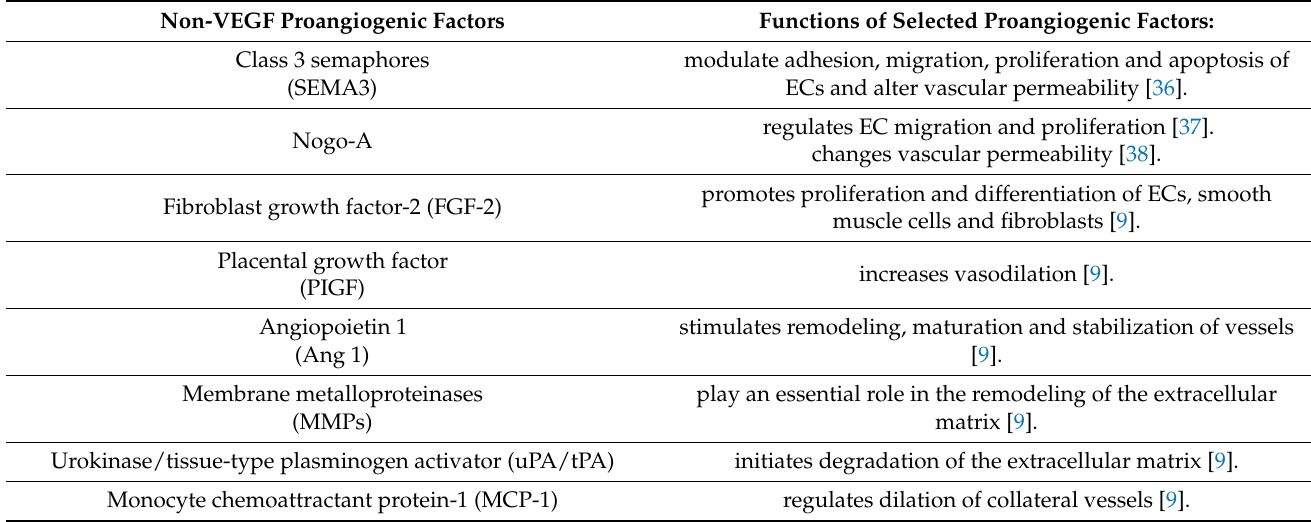
Table 1. Functions of selected proangiogenic